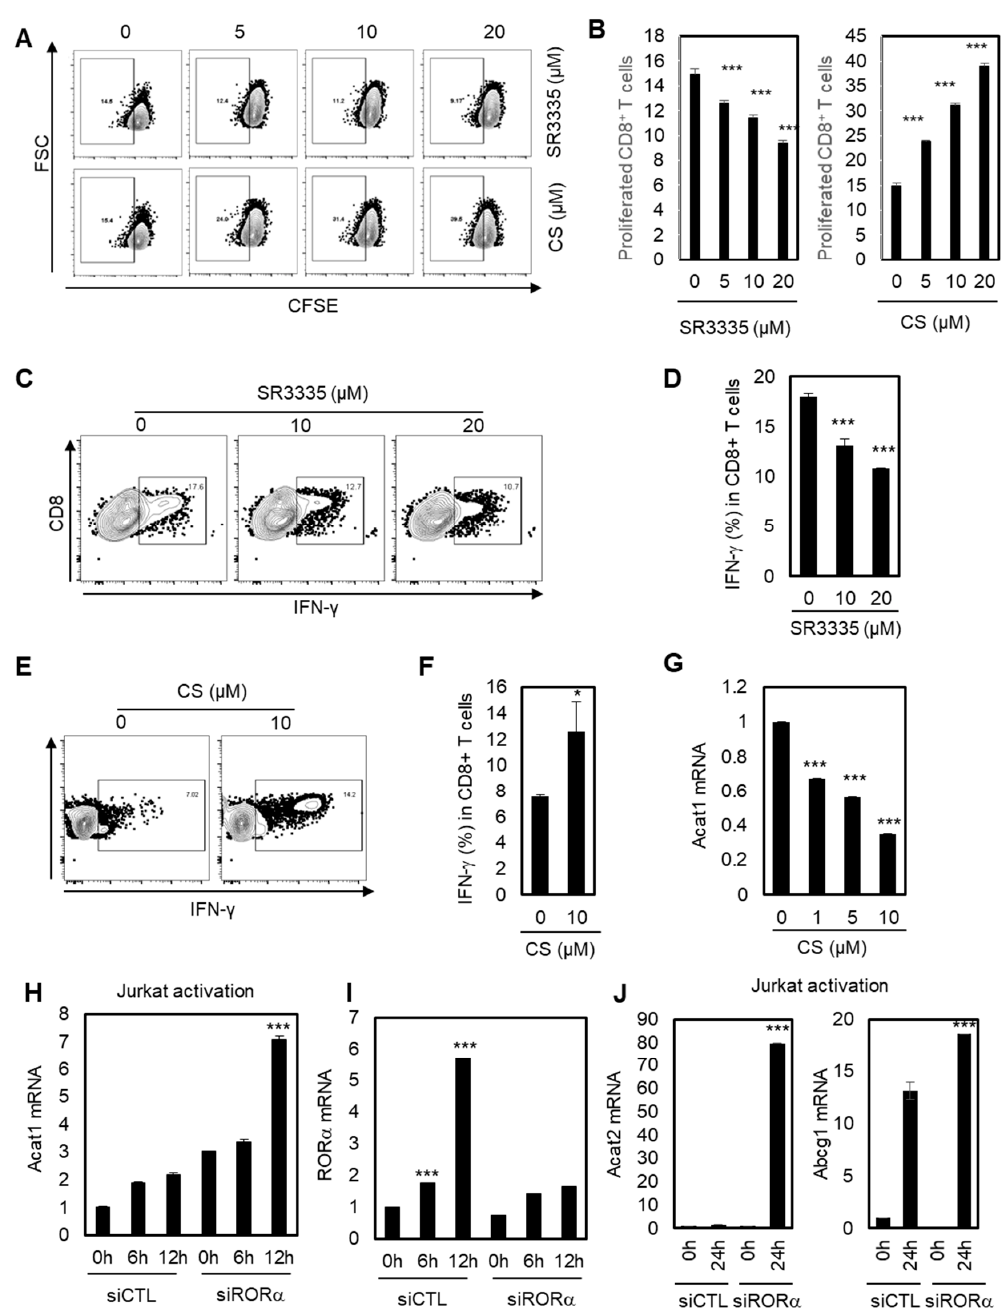
Figure 3. ROR α potentiates CD8 + T cells through cholesterol esterification. ( A ) Dot plot analysis for the proliferation of CD8 + T cells treated with CS at doses of 5, 10, and 20 µ M, or SR3335 at doses of 5, 10, and 20 µ M. ( B ) Quantification of dot plat analysis in Figure 3A. The p -value was calculated by a t -test (*** p < 0.001). ( C,E ) IFN- γ production of CD8 + cells treated with 0, 10, and 20 µ M of SR3335 (C) or 0 and 10 µ M of CS (E). ( D,F ) Quantification of IFN- γ production of CD8 + cells treated with SR3335 (D) in Figure 3C or CS (F) in Figure 3E. The p -value was calculated by a t -test (* p < 0.05, *** p < 0.001). ( G ) Transcriptional level of Acat1 in CD8 + cells treated with CS. The p -value was calculated by a t -test (*** p < 0.001). ( H – J ) Jurkat cells were transfected with either siRNA for control (siCTL) or siRNA of ROR α , and the cells were activated at the indicated times. Transcriptional levels of Acat1 (H), ROR α (I), and Acat2 / Abcg1 (J) were measured. The p -value was calculated by a t -test (*** p < 0.001).